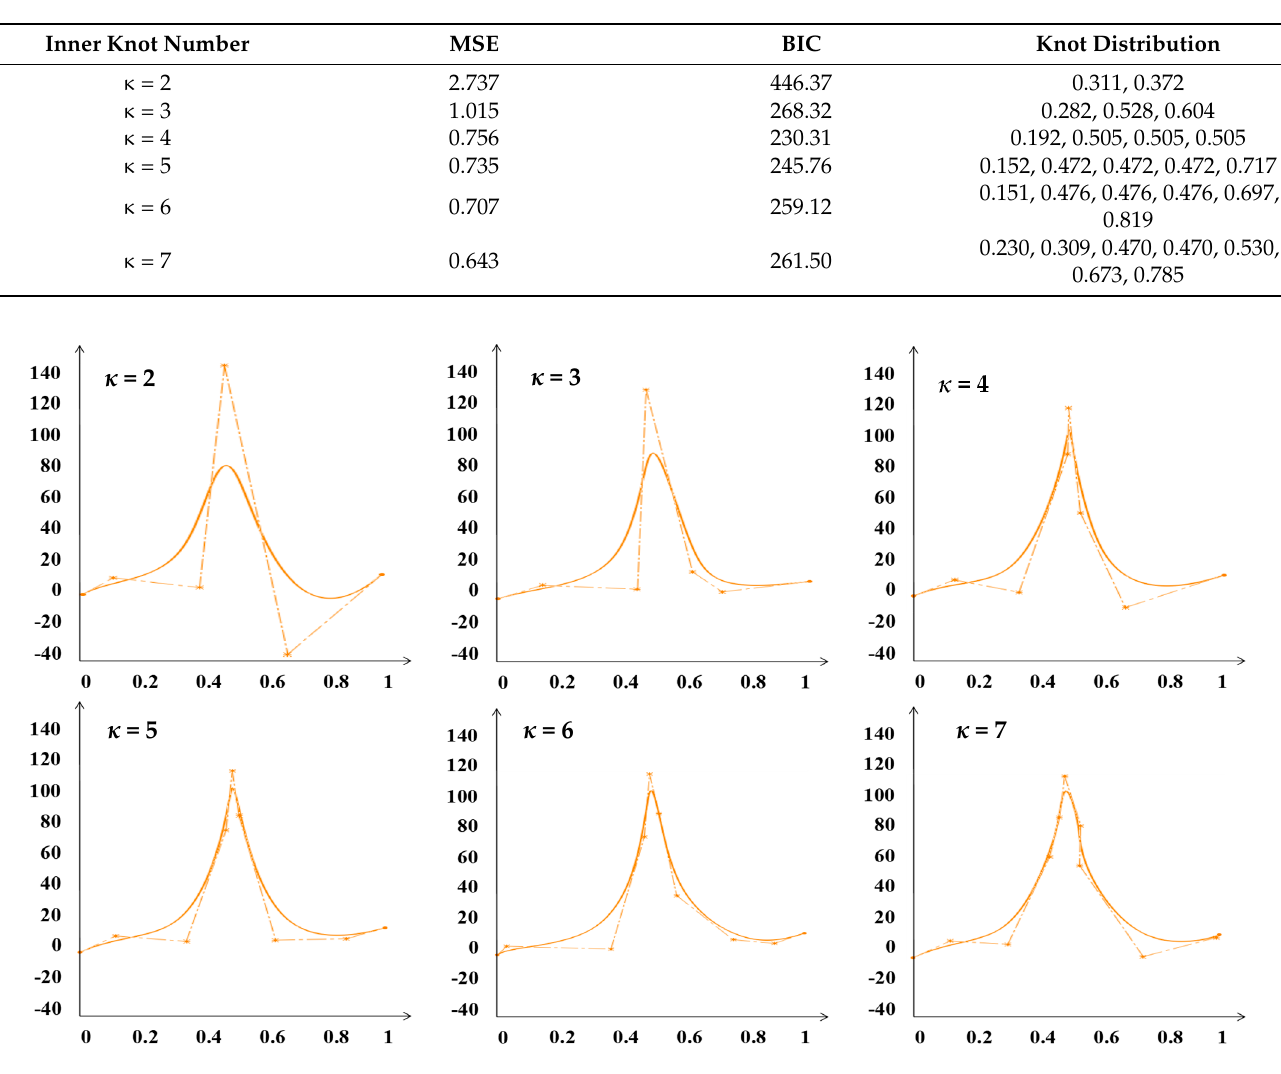
Table 6. BIC value and knot distribution of HPA with different knot number.